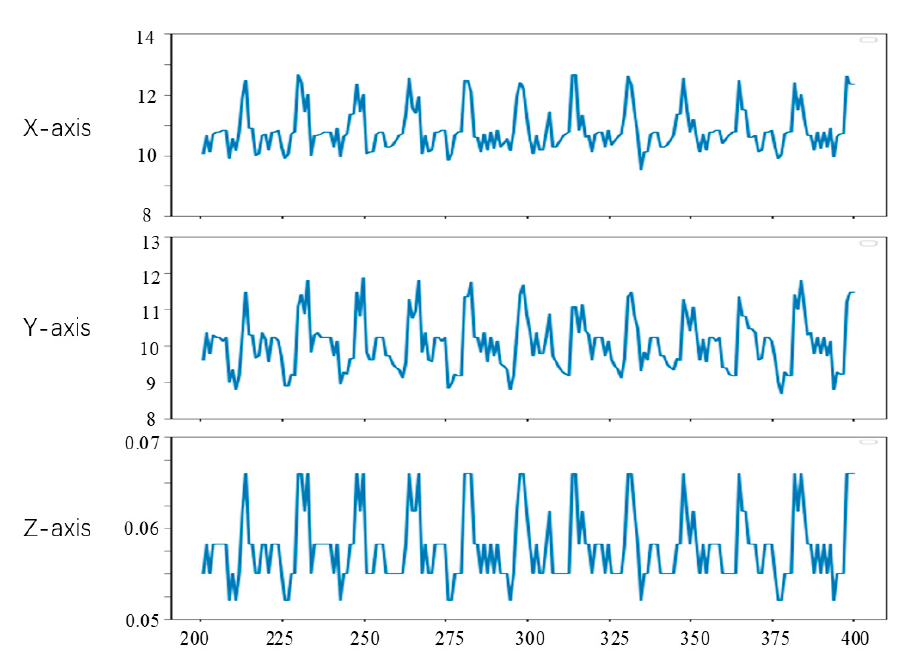
Figure 16. Point b motion tracking results.